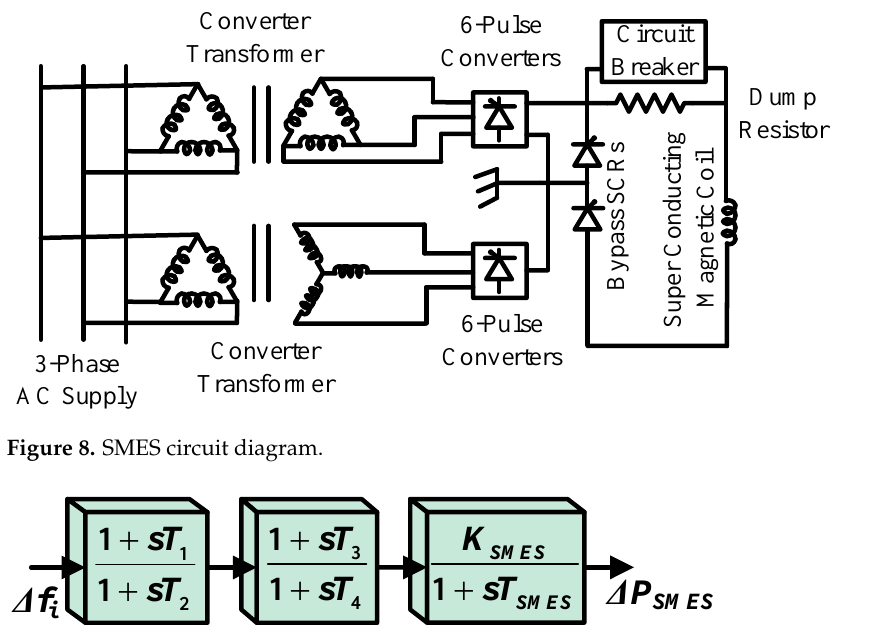
Figure 8. SMES circuit diagram.